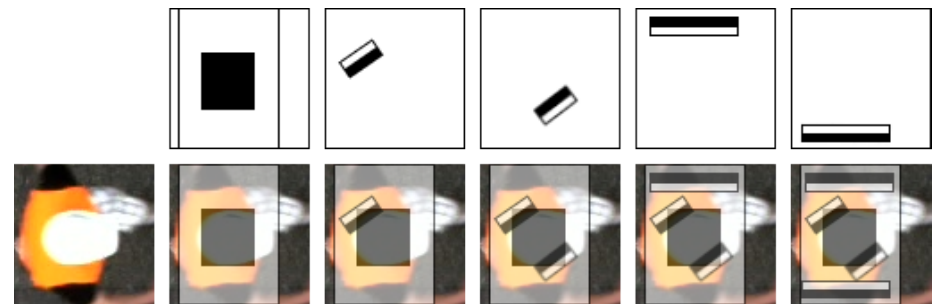
Figure 5. Iterative feature selection by AdaBoost (from left to right). A shape model is learned from Haar-like features. The first three iterations approximate the worker’s head while the following two focus on the worker’s